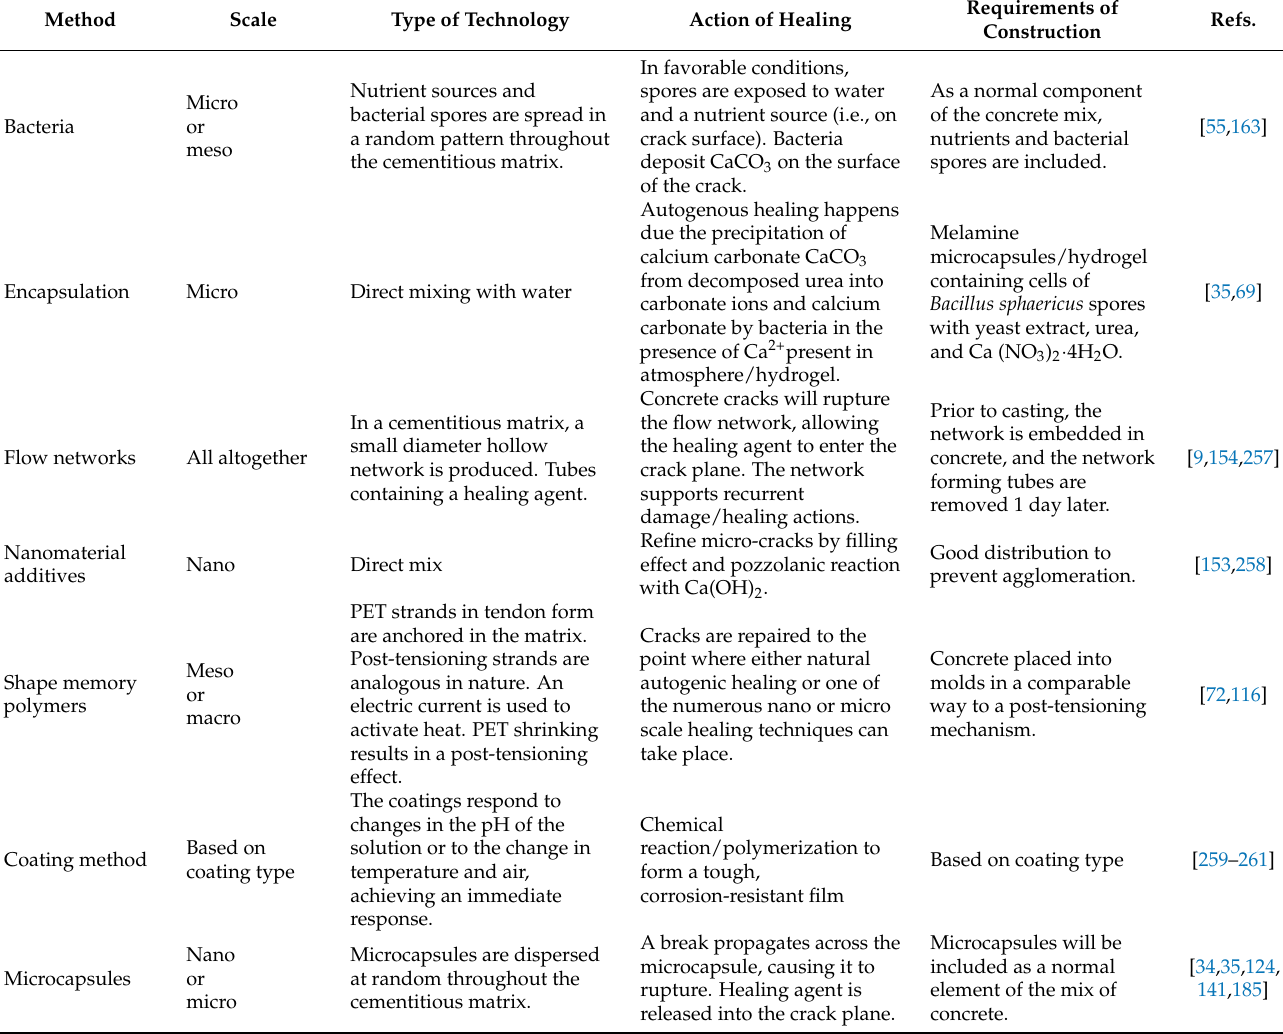
Table 8. Details of self-healing methods (Adapted with improvements from